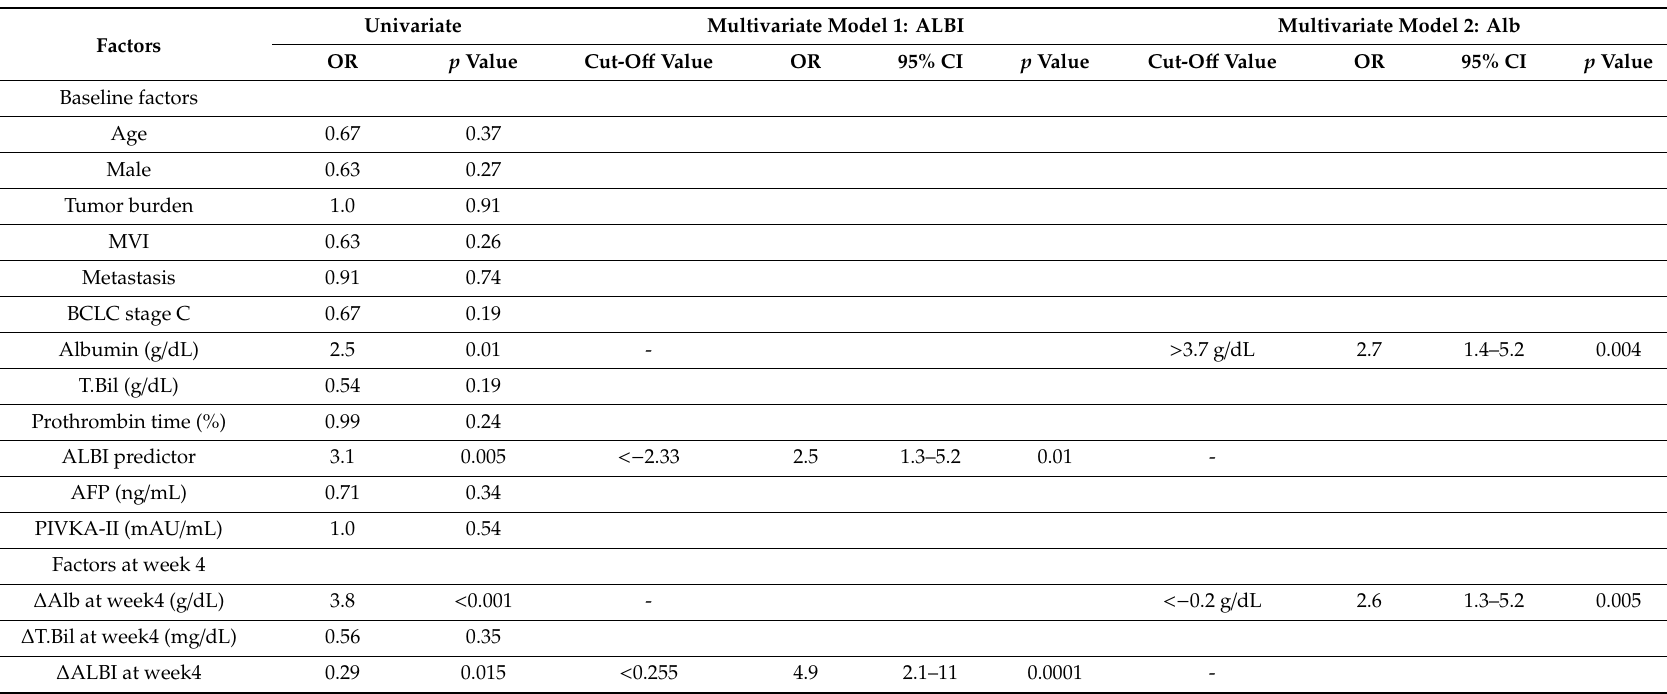
Table 2. Factors to fulfill the RESORCE study’s inclusion criteria at the time of radiological progressive